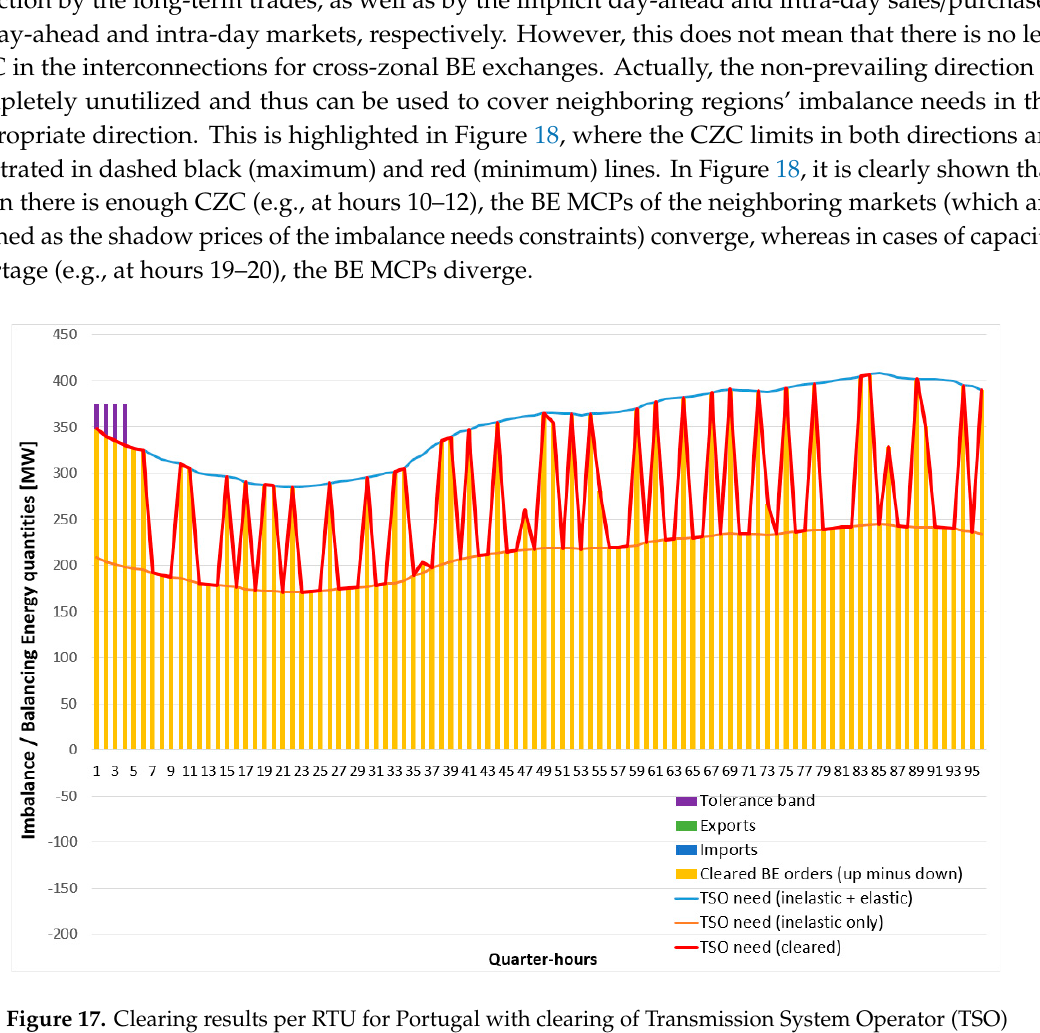
Figure 17. Clearing results per RTU for Portugal with clearing of Transmission System Operator (TSO) needs in the tolerance band. needs in the tolerance